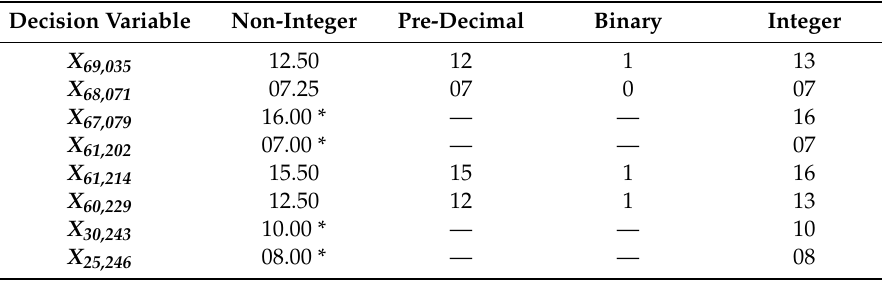
Table 6. Final optimal